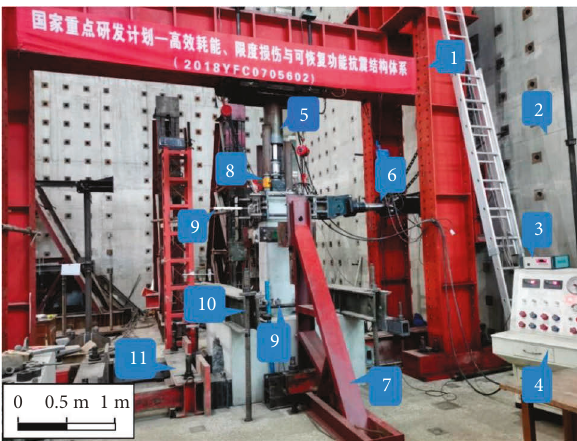
Figure 10: Experimental layout. 1, loading frame. 2, reaction wall. 3, statical strain indicator. 4, control table. 5, hydraulic Jack. 6, 500 kN actuator. 7, lateral support. 8, load sensor. 9, displacement gauge. 10, fixed beam. 11, horizontal support Table 5: The test case design and loading scheme.